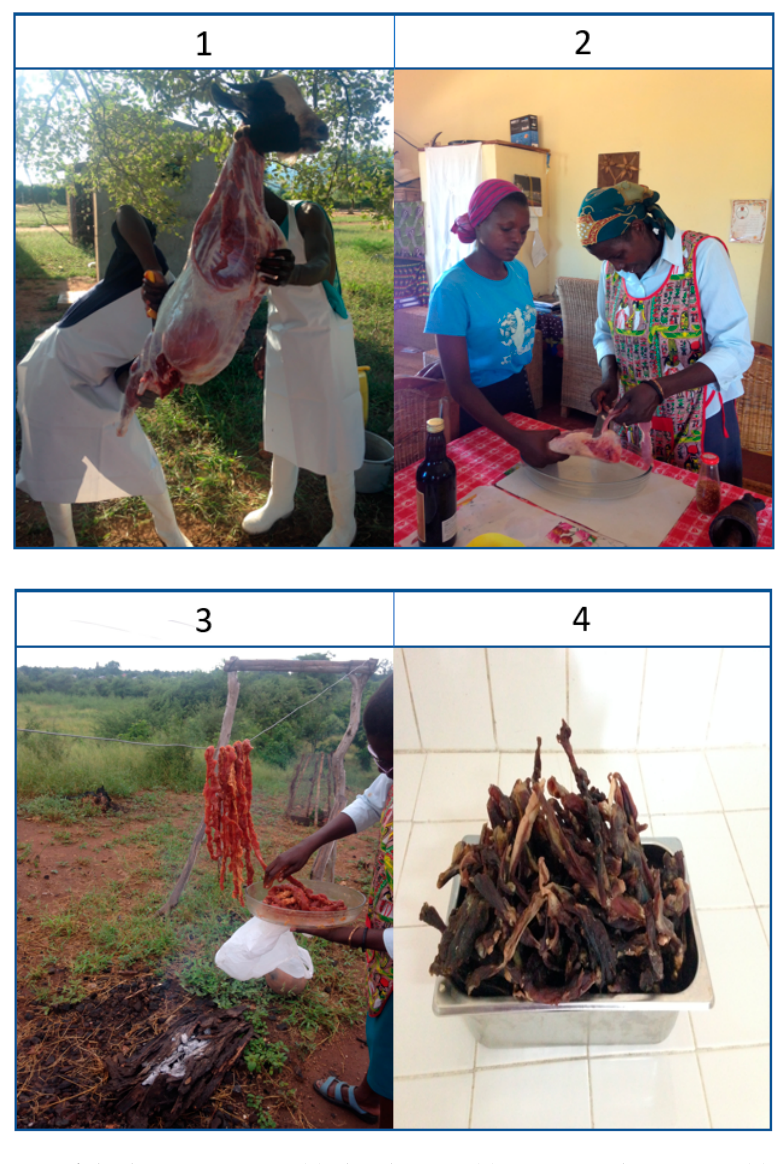
Figure 2. Stages of chinkui preparation: (1) Slaughtering; (2) Cutting and seasoning; (3) Strips hung out to dry; (4) chinkui dried meat.